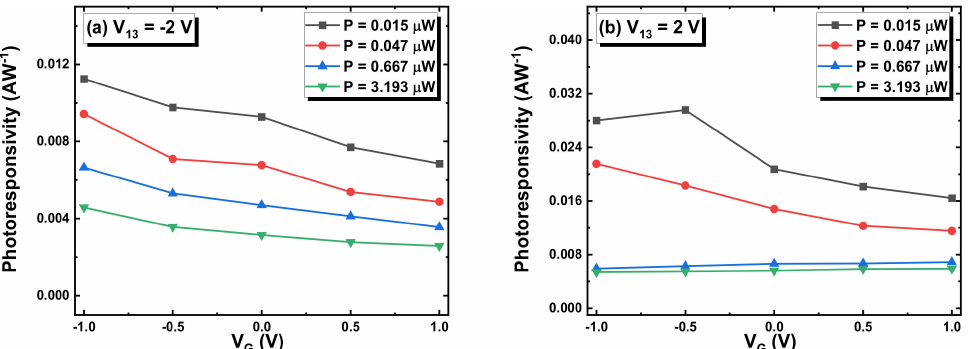
Figure 8. Gate voltage and laser power dependence of the photoresponsivity in p -WSe 2 /n-SnSe 2 heterostructure-based TFET at ( a ) negative and ( b ) positive polarization